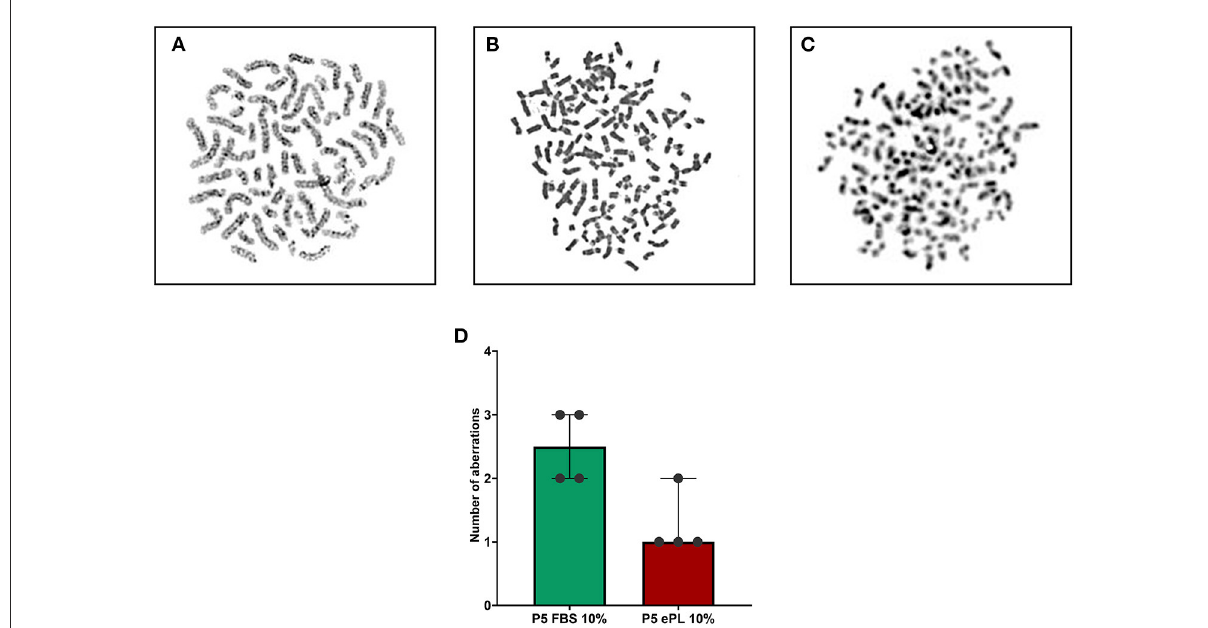
FIGURE2 GTG karyotype analyses on metaphases from equine mesenchymal stromal cells (MSC) after cultivation in 10% fetal bovine serum (FBS) or 10% equine platelet lysate (ePL). The upper images display examples of metaphase cells with a normal karyotype (A) , polyploidy (B) , and premature centromeric division (C) . The bar plot (D) displays the number of abnormal cells found per 25 metaphase cells from each sample ( n = 5 per group; the difference was not statistically